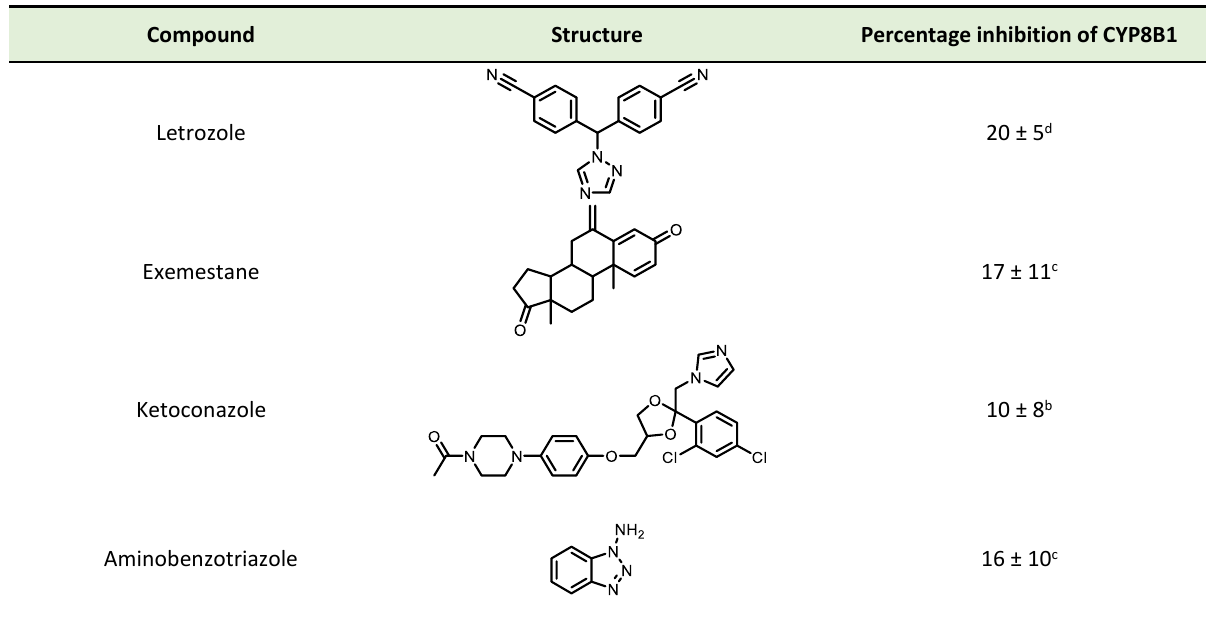
TABLE 1. Effect of inhibitors on CYP8B1